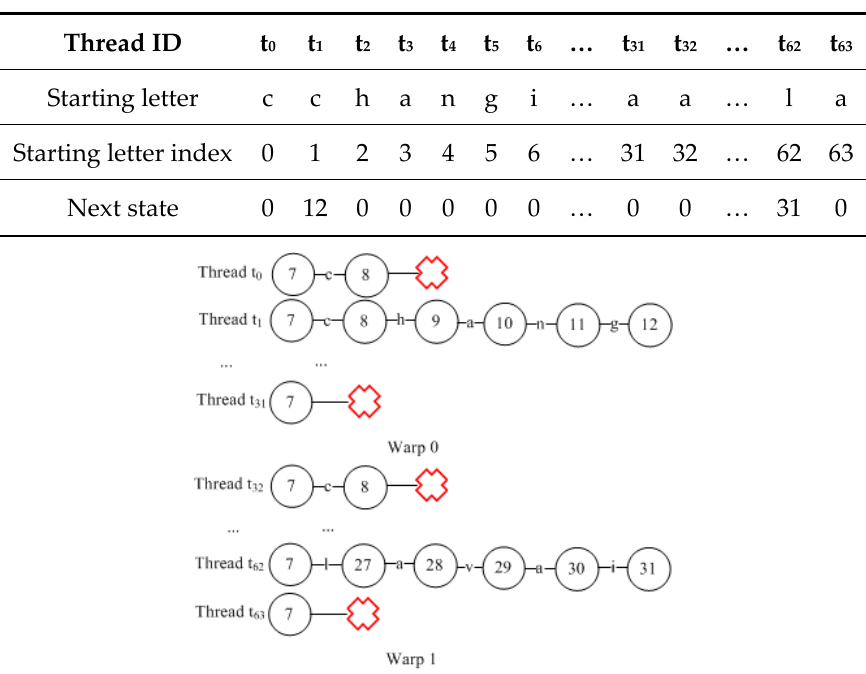
Figure 6. The next state for each thread after reaching the threshold, which is set to 5.